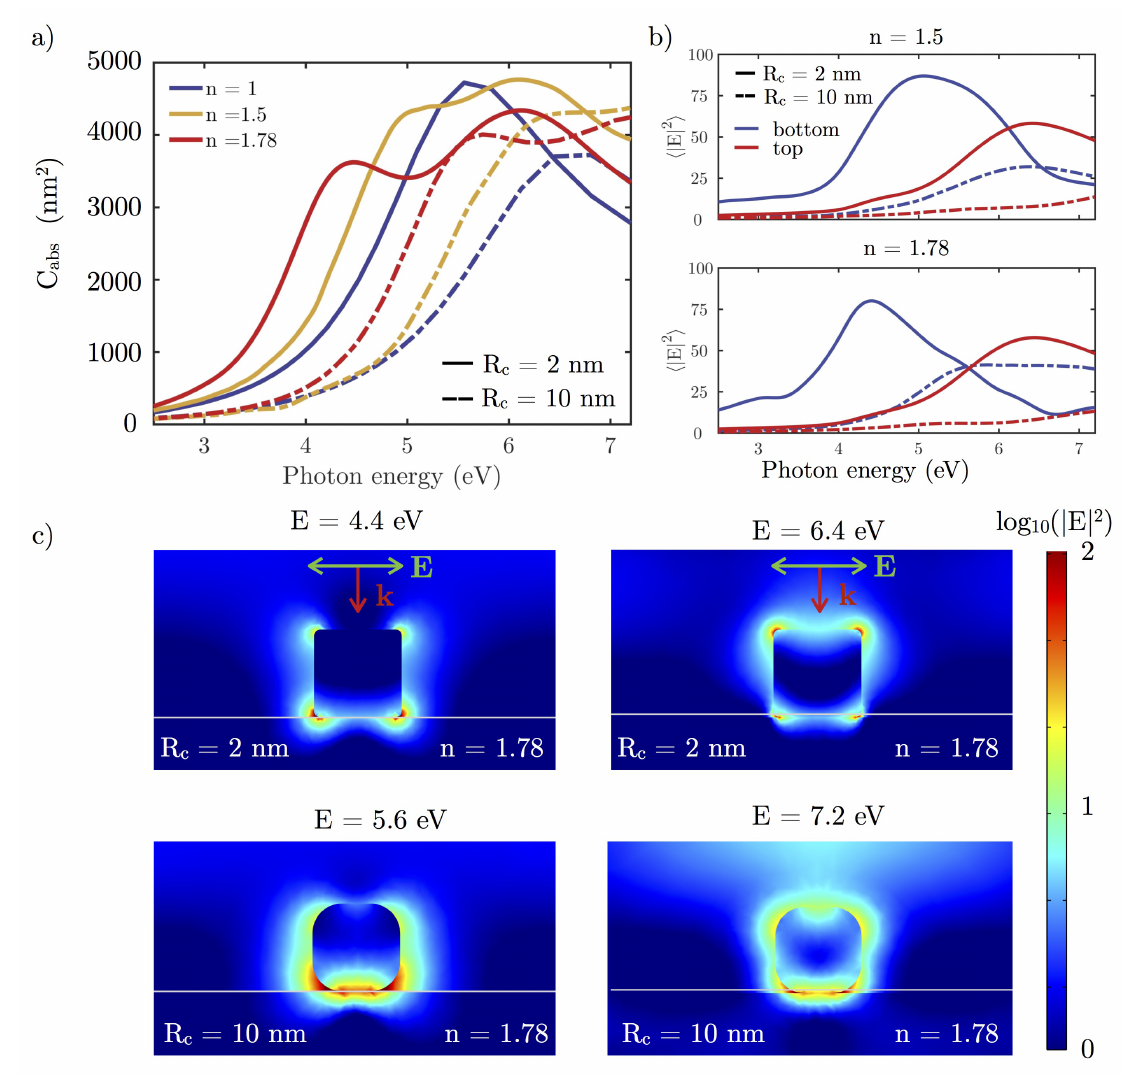
Figure 9. ( a ) absorption cross-section ( C abs ) of a L = 30 nm and R c = 2/10 nm (solid/dashed line) Rh NC under normal incidence with a P-polarization beam on substrates with different refractive indexes; ( b ) | E | 2 averaged over the corners and edges in the bottom (contact with the substrate, blue line) and top (red line) faces of the cube on a glass ( n = 1.5) and sapphire ( n = 1.78) substrates; ( c ) logarithmic scale | E | 2 near-field maps for R c = 2/10 nm Rh NC (top/bottom) on sapphire substrate ( n = 1.78 ) at E = 4.4/5.6 eV and E = 6.4/7.2